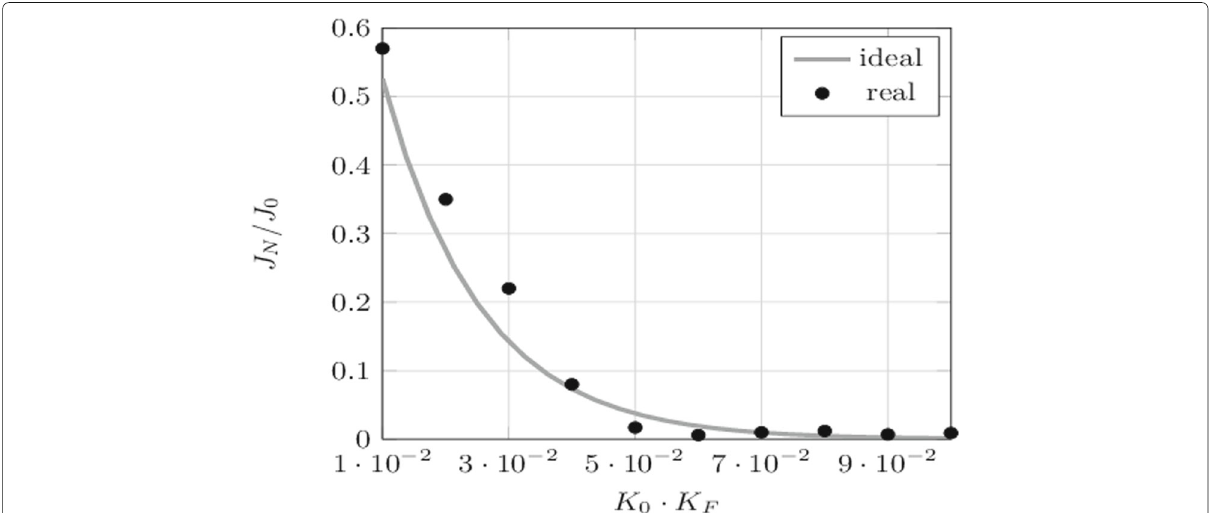
Fig. 14 Convergence of our symbol timing recovery sub-system. We plot the final relative jitter, when N = 64, varying the filter DC gain and VCO sensitivity product, SNR = 2 dB